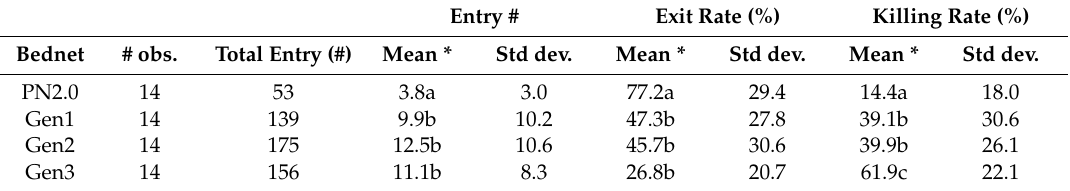
Table 1. Results from field evaluations in Tiassale (Cote d’Ivoire) where mosquitoes are resistant to insecticides of Gen1, Gen2, and Gen3 T-Nets compared to the Permanet 2.0 (PN2.0)-LLIN. Shown are the total mosquitoes caught, mean entry rate, mean exit rate, and mean mortality rate per hut per night for An. gambiae s.l mosquitoes after 14 observations.